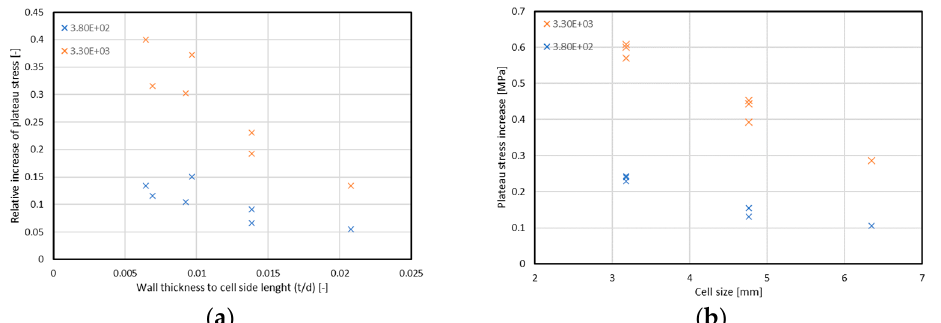
Figure 12. Relationship between value of relative increase in plateau stress and ( a ) ratio of wall thickness to the single core cell height, ( b ) core cell size.